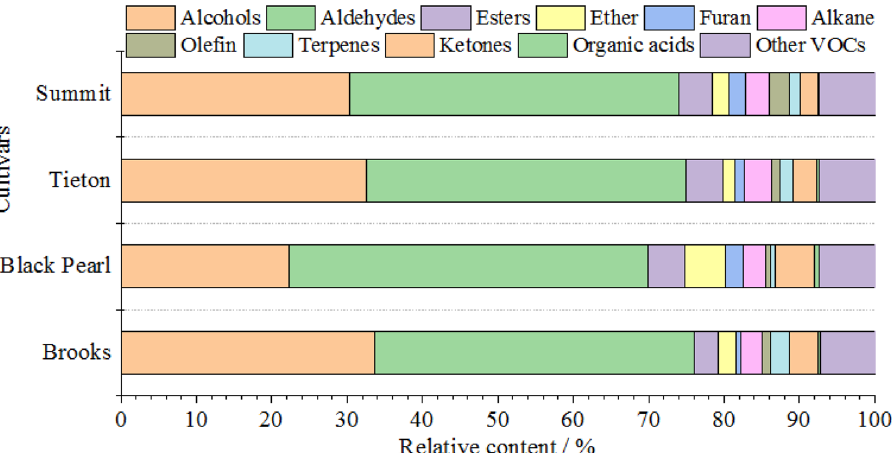
Figure 6. Relative contents of volatile organic compounds of sweet cherry flower essential